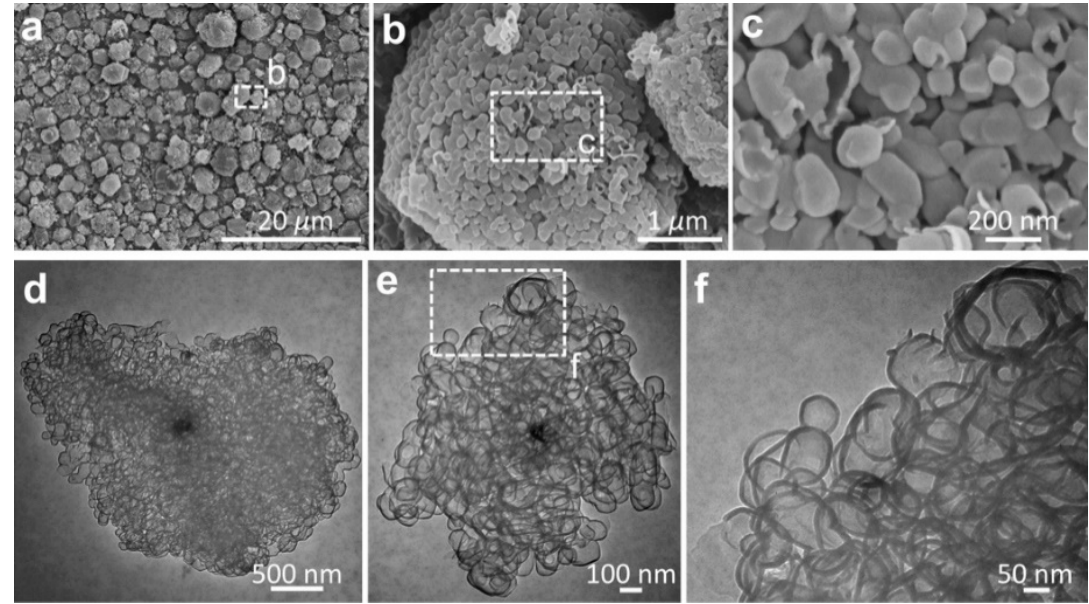
Figure 3. ( a − c ) SEM images and ( d − f ) TEM micrographs showing the mesopores of graphene. The Figure 3. ( a – c ) SEM images and ( d – f ) TEM micrographs showing the mesopores of graphene. The host host MgO templates were etched in 1 M HCl solution prior to the morphological observations. MgO templates were etched in 1 M HCl solution prior to the morphological